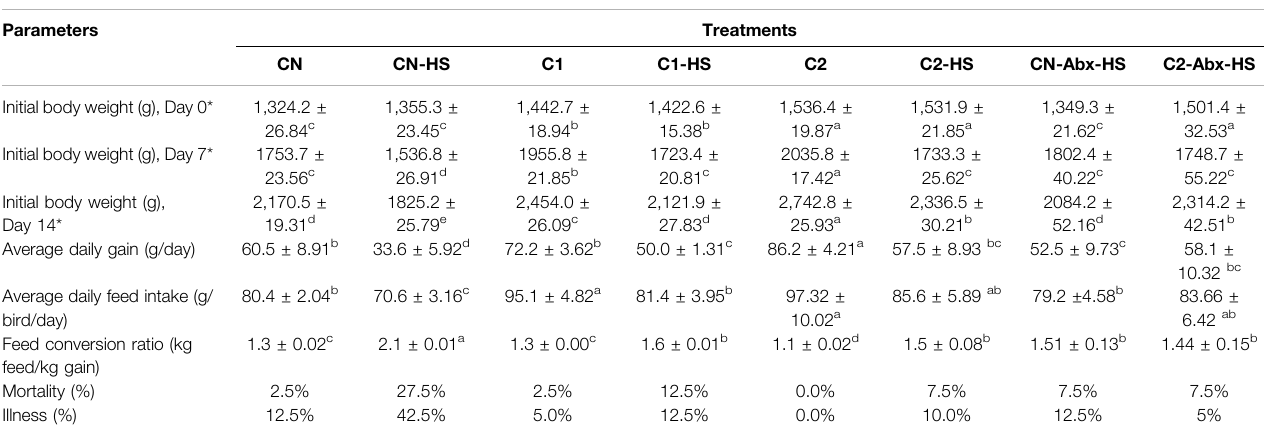
TABLE 2 | Effect of chronic heat stress on chicken performance.